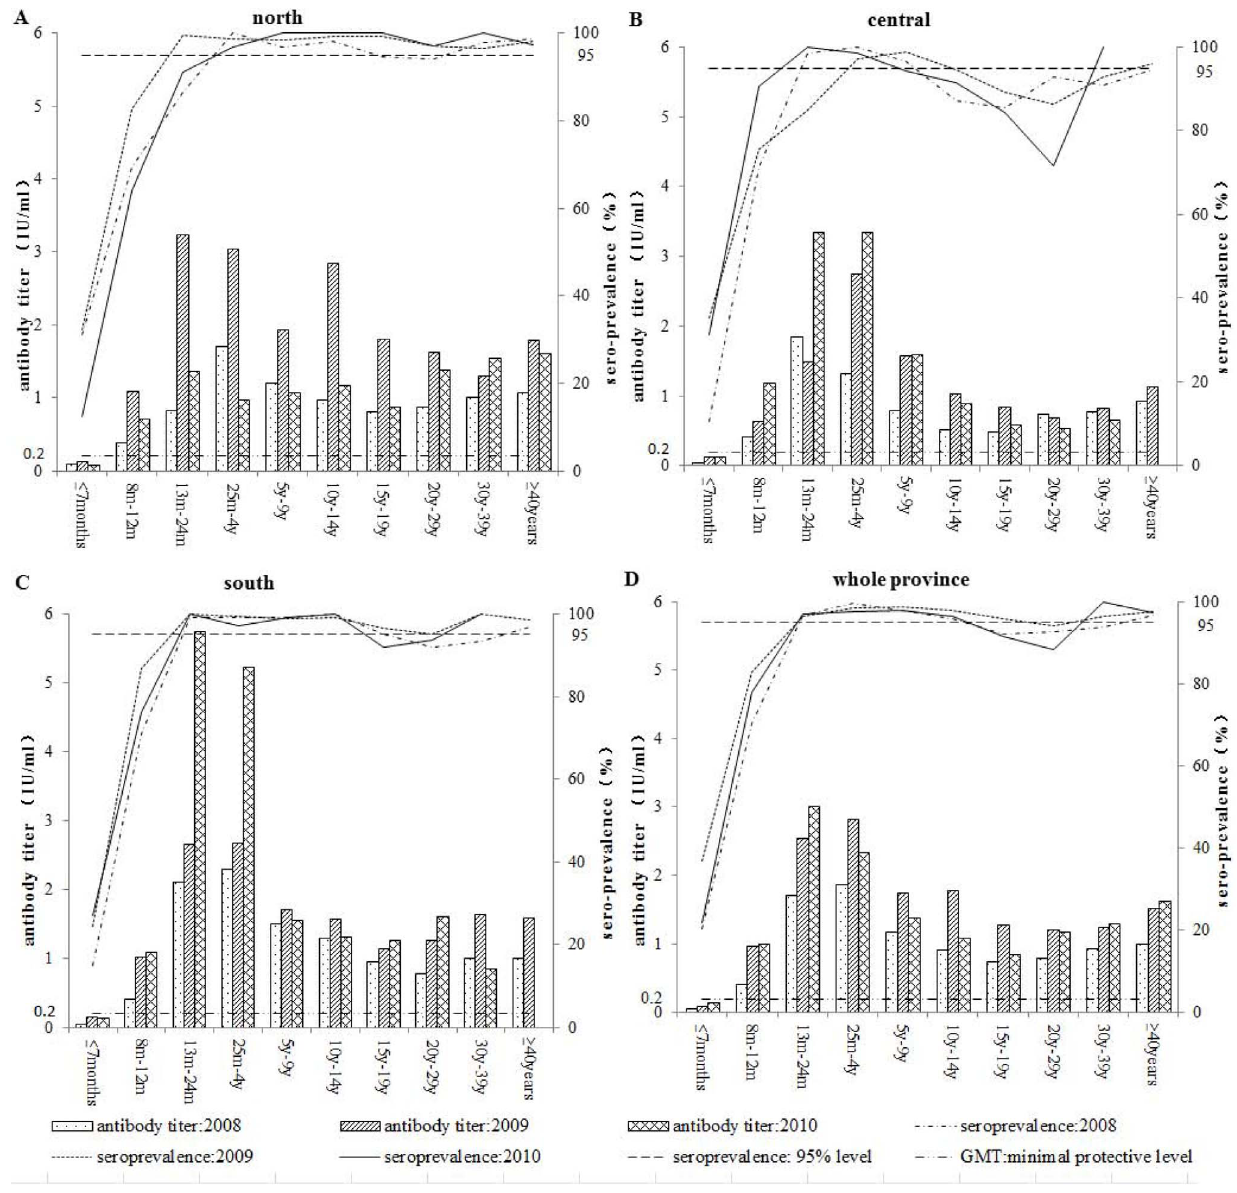
Figure 1. Region-specific geometric mean titers (GMTs) and prevalence of measles antibodies in different age groups from 2008– 2010. The seroprevalence in each region showed an upward trend with age: the GMT climbed to a peak between 13 months - 4 years of age followed by a downward trend in subsequent ages (A, B, and C), similar to what was seen throughout the whole province (D). The seroprevalence in the central region declined dramatically in individuals 15–29 years old in 2010